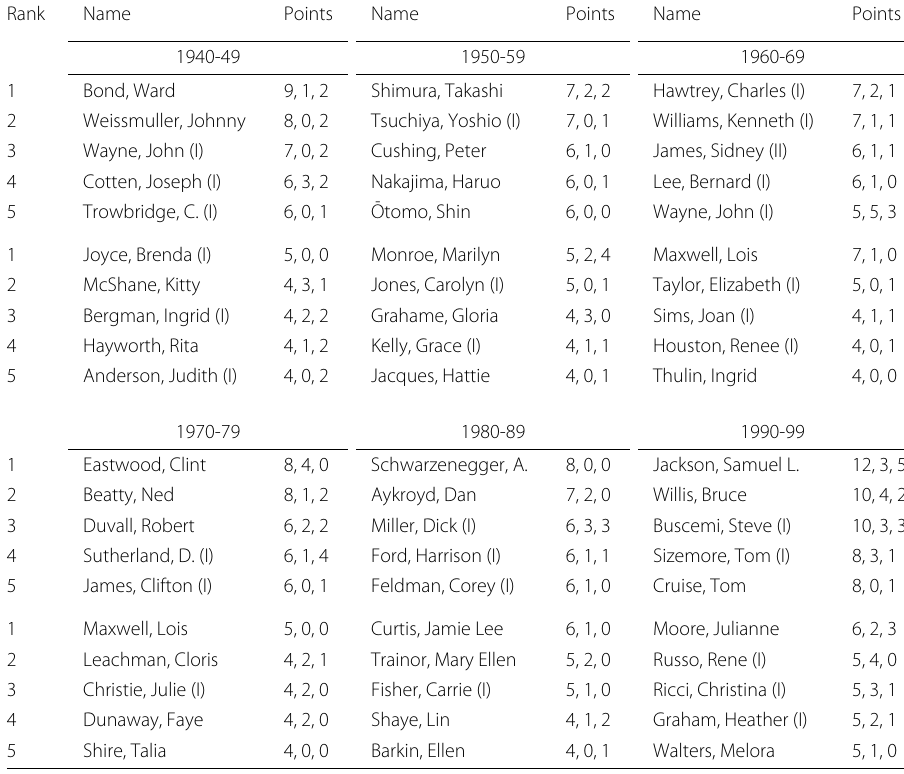
Table 9 Top 5 actors and actresses by decade, from the 40’s to the 90’s